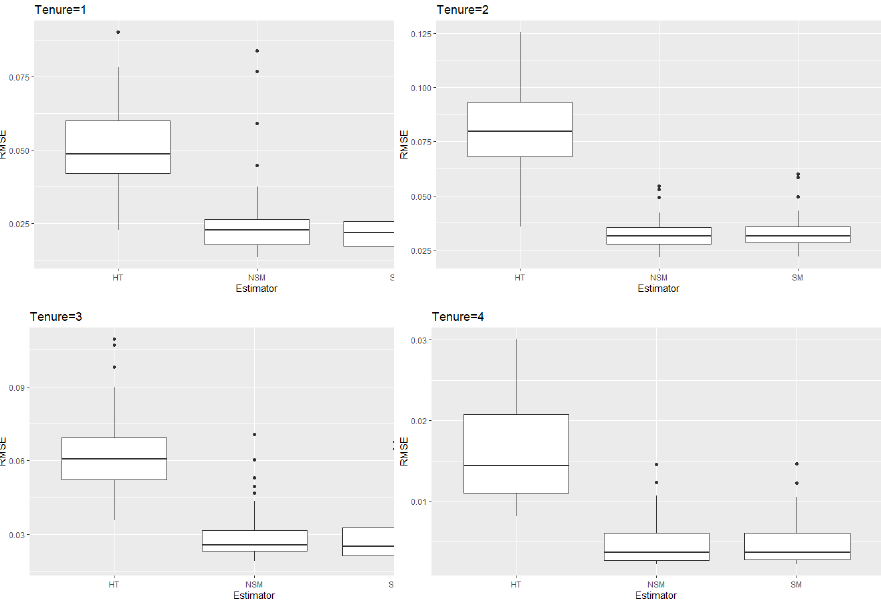
Figure A2. Boxplots of the 49 state RMSEs for the 3 methods: HT Multinomial, Non-Spatial Multi- nomial, and Spatial Multinomial. Data are based on the multinomial simulation using Week 1 of the Household Pulse Survey. The response variable is housing status: own home with mortgage (Tenure = 1), own home free and clear (Tenure = 2), rent (Tenure = 3), and rent but unable to pay (Tenure =